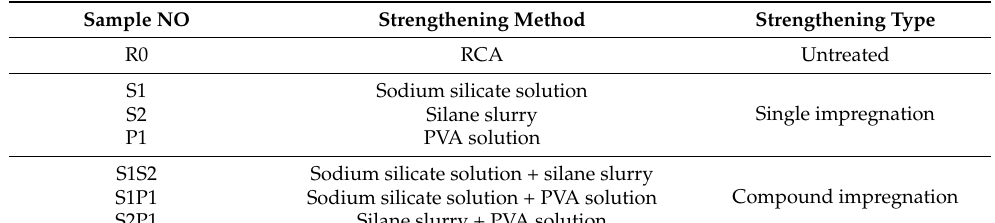
Table 1. Impregnation treatment scheme.